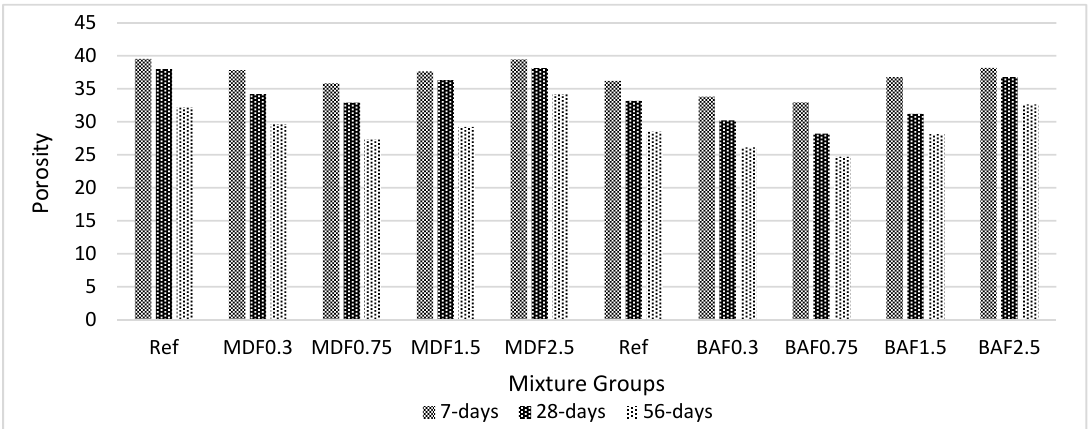
Figure 7. E ff ect of carbon fiber on porosity for marble and bottom ash mixture groups at 7, 28, and 56 days of curing.